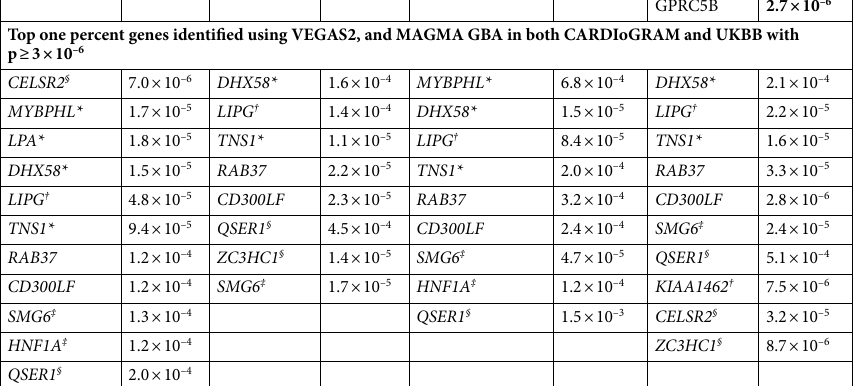
Table 1. Top enriched genes identified using VEGAS2, and MAGMA GBA in CARDIoGRAM and Pan UK Biobank (UKBB). Top one percent of the ranked genes in either VEGAS2 or MAGMA GBA are defined as top enriched genes. P values of significant genes (p ≤ 3 × 10 –6 ) highlighted in bold. Genes highlighted in italics were identified using VEGAS2, and MAGMA GBA in CARDIoGRAM and UKBB (Pan UK Biobank). *Previously reported by Svishcheva et al. 23 . † SNVs in corresponding genes previously reported by Van der Hast et al. 6 . ‡ SNVs in corresponding genes previously reported by Nelson et al. 29 . § SNVs in corresponding genes previously reported by Hartiala et al. 21